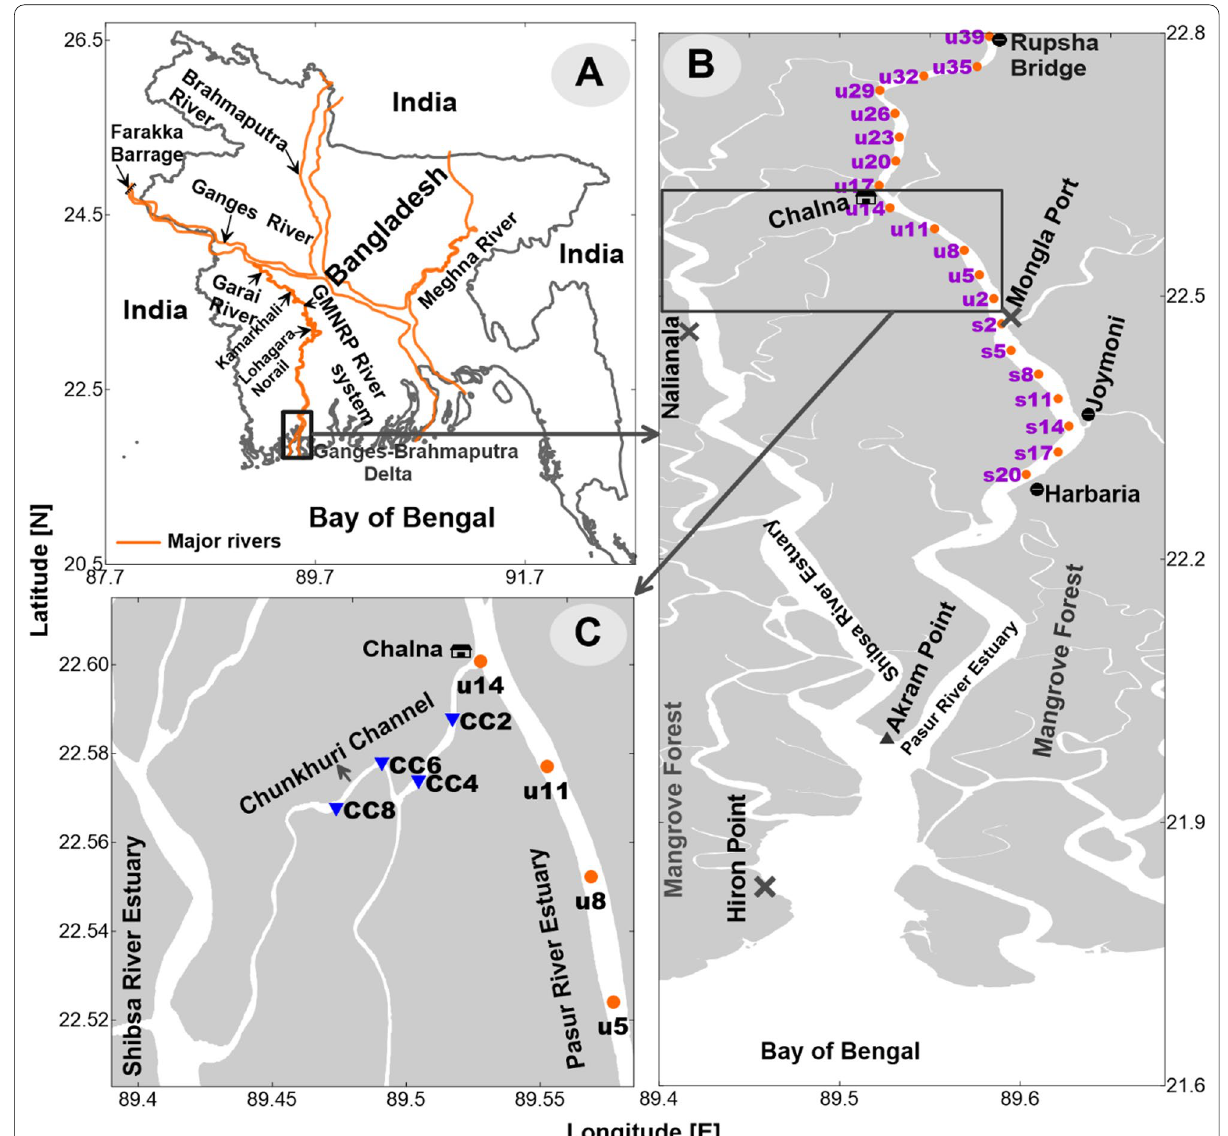
) in the Pasur River. The X